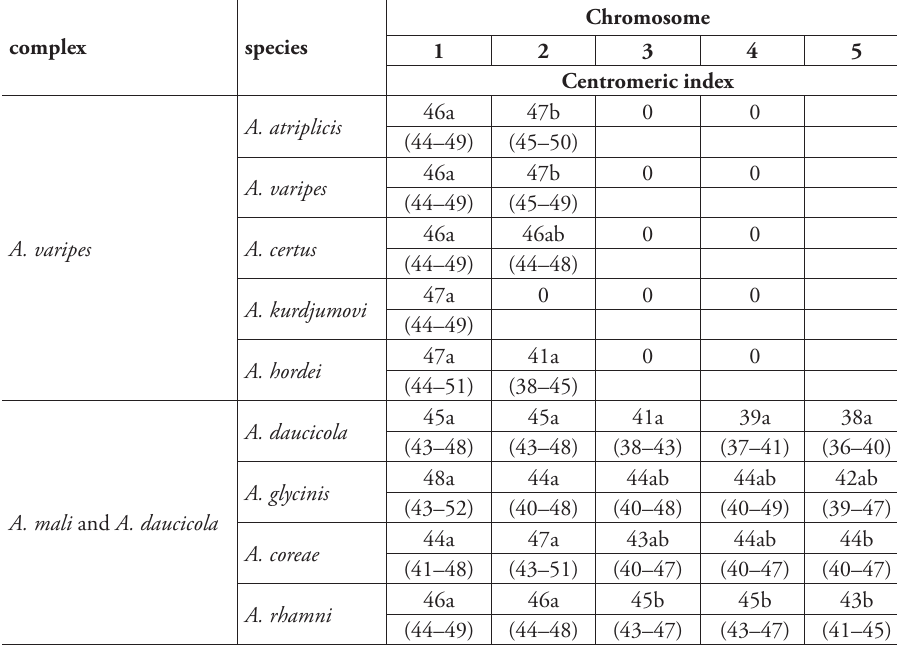
Table 5. Centromeric indexes of chromosomes in Aphelinus species . Means (95% confidence intervals); shared letters within a species complex and chromosome indicate means that are not significantly different.